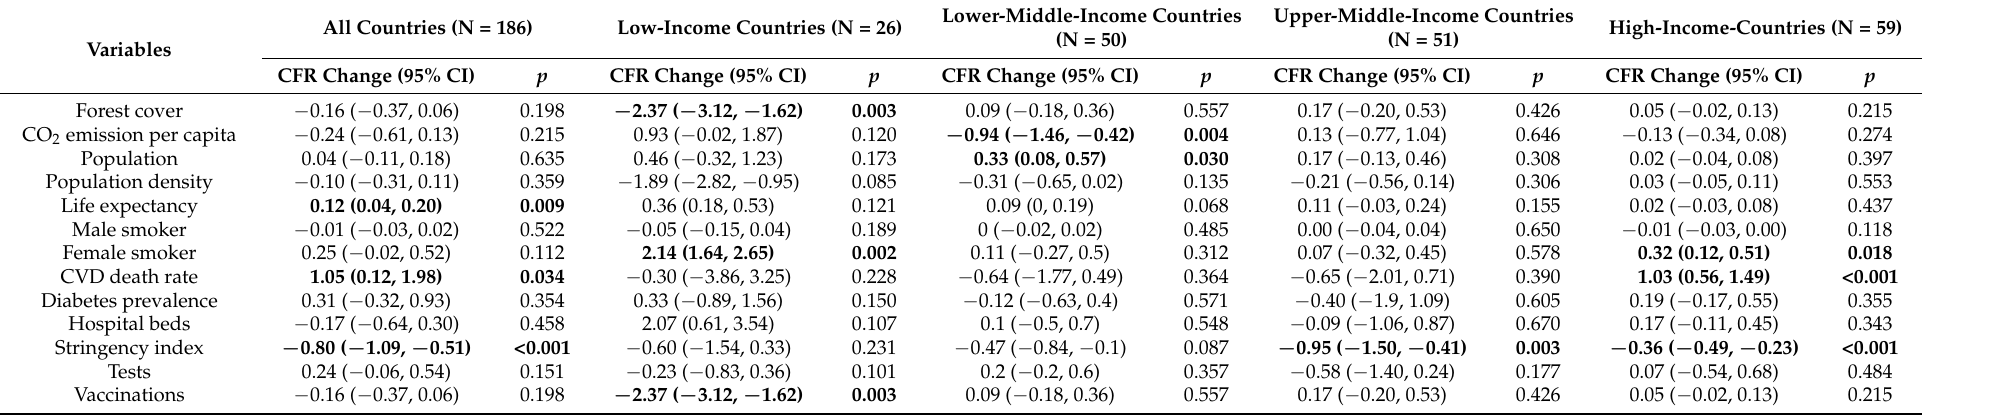
Table 2. Changes in COVID-19 CFR (‰) per 10% increase in the ecological and socioeconomic variables.